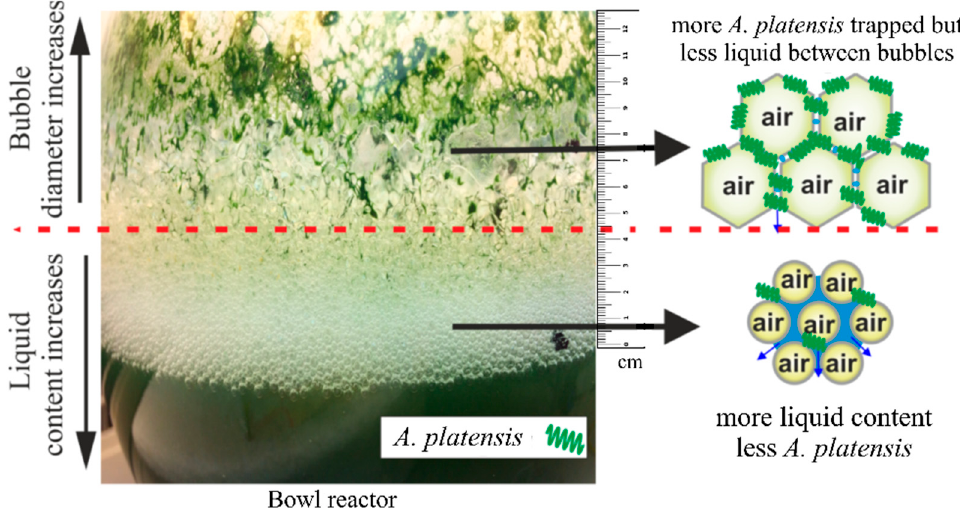
Figure 1. Formation of stable CO 2 bubbles at different foam heights.